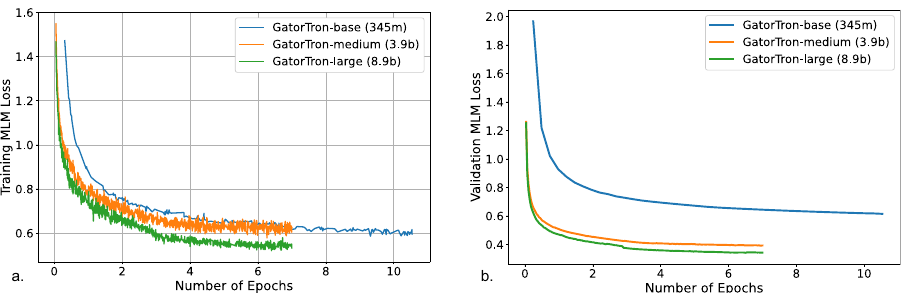
Fig. 2 Training loss and validation loss for GatorTron-base (345 million), medium (3.9 billion), and large (8.9 billion) models. a Training loss. b Validation loss. MLM masked language modeling.